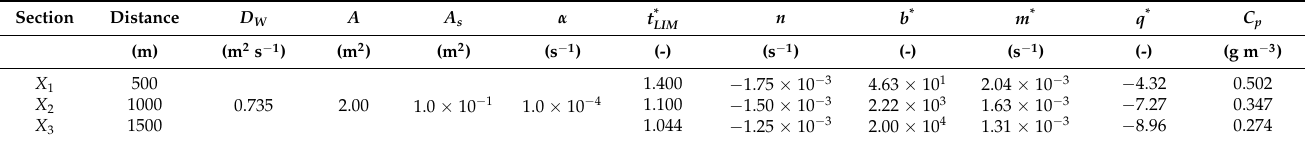
Figure 2. BTCs generated by the TSM model at X 1 = 500 m, X 2 = 1000 m and X 3 = 1500 m and approximations for ( a ) the decreasing limb in semi-log scale and for ( b ) the rising limb in linear scale. Table 1. TSM parameters A , A S , D W , and α are used for the concentration curves in Figure 2, coefficients m ∗ , q ∗ , b ∗ , and n of the approximation trendlines for the decreasing and rising parts at the three output sections X i , and peak concentration C p at each section used for normalizing the BTC in Figure 2.